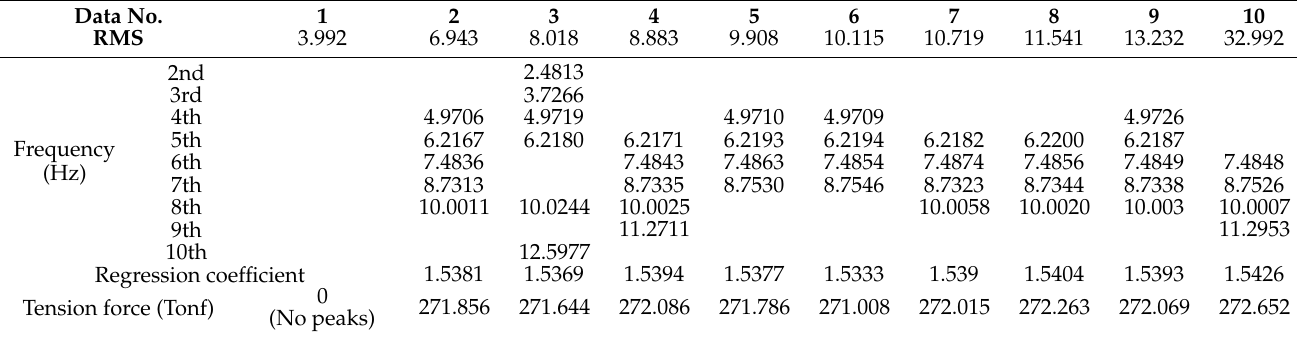
Table 3. Results of cable tension estimation with varying